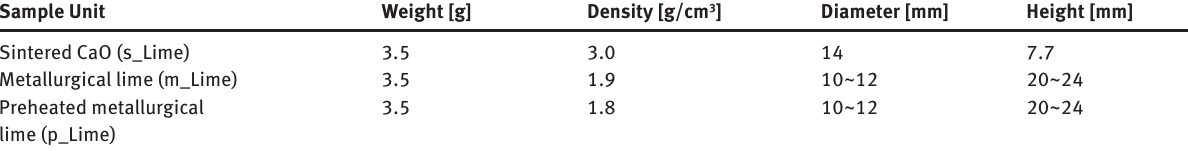
Table 1: Properties of three kinds of lime